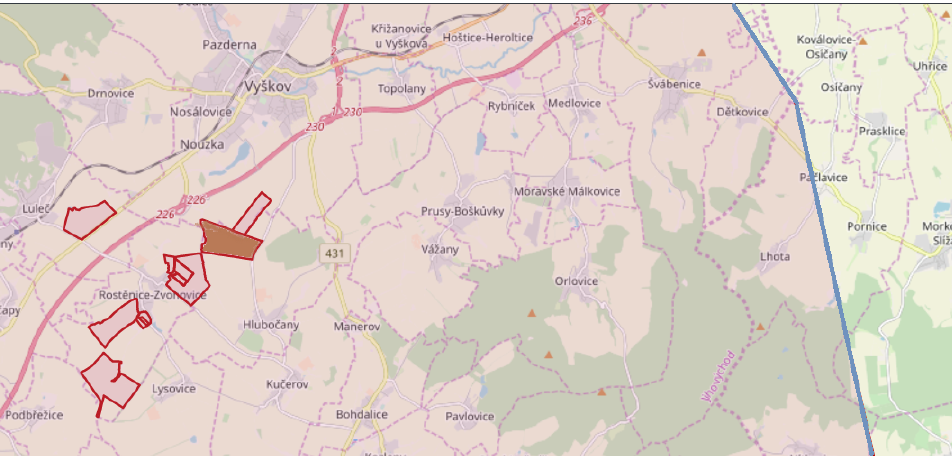
Figure 10. Fields which grew maize for silage during 2019 within the South Moravian